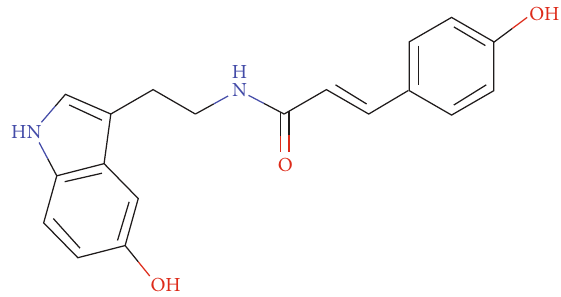
Figure 4: Molecular structure of N -p-coumaroylserotonin H N O ; MW = 322 : 13 g/mol ). (C 19 18 2 3